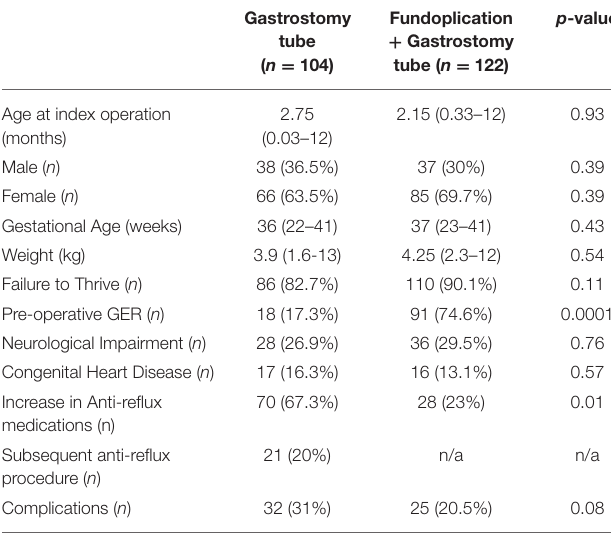
TABLE 1 | Comparison of patients with initial GT alone vs. GT with ARP.